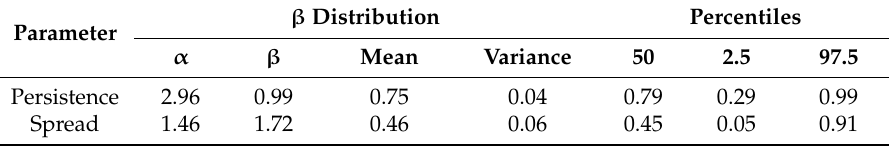
Table 1. Prior distributions for persistence and spread elicited from the expert panel. β Distribution Percentiles Parameter α β Mean Variance